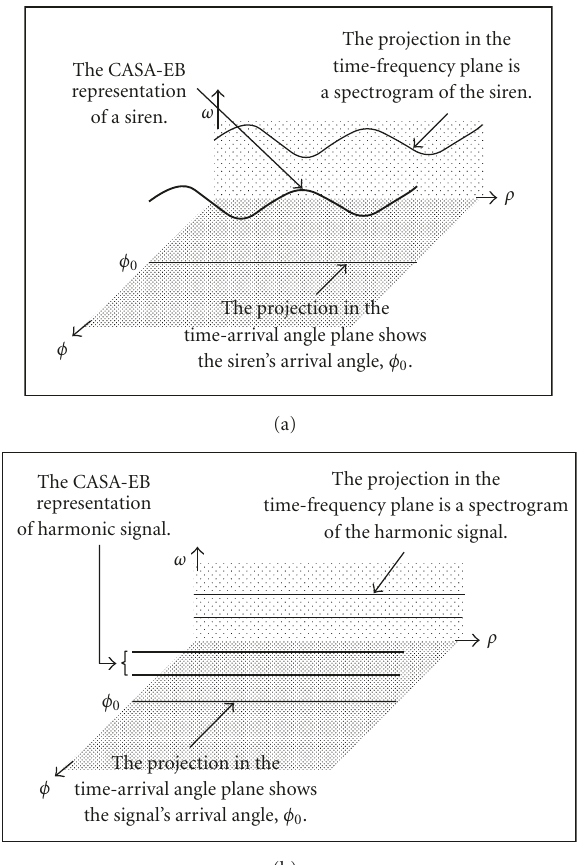
Figure 2: CASA-EB representations of a siren (a), and a simple harmonic signal (b). The projections on the time-frequency plane (signal’s spectrogram) and time-arrival angle planes (signal’s arrival angle path) are also shown.